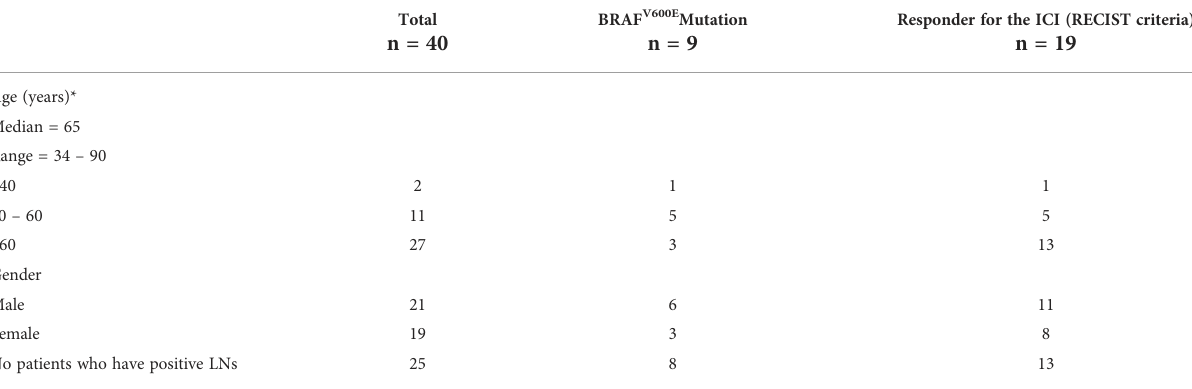
TABLE 1 Clinicopathological features of the melanoma patients (refer to Supplementary Text ).